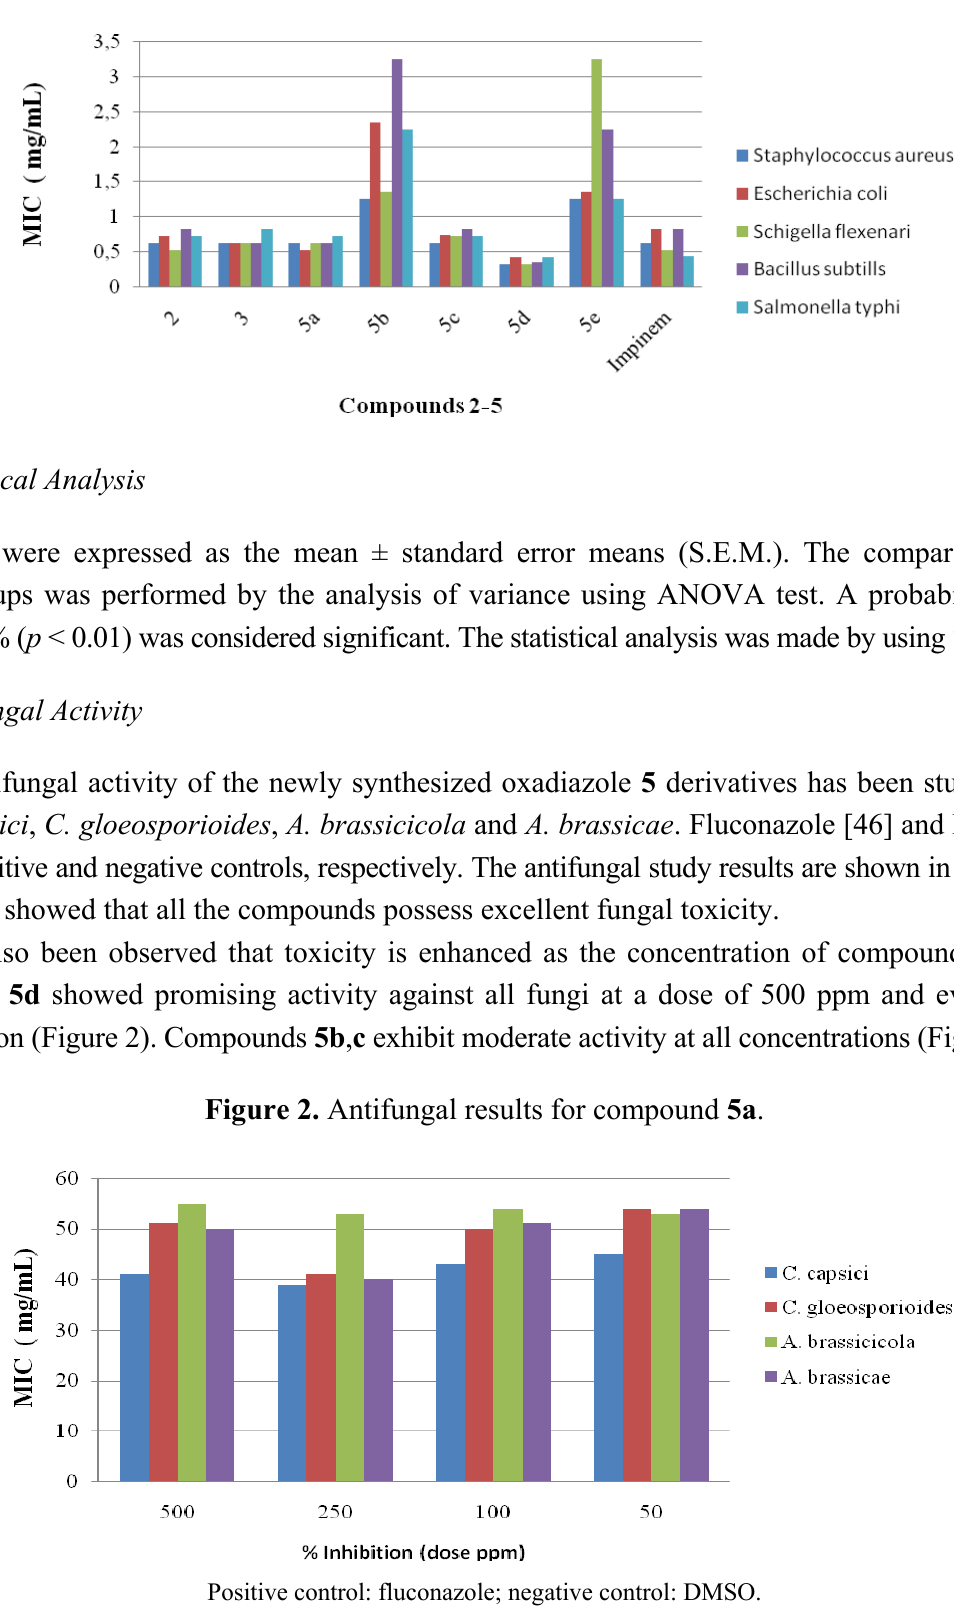
Figure1. MIC value of the synthesized compounds 2 – 5 in mg/mL.